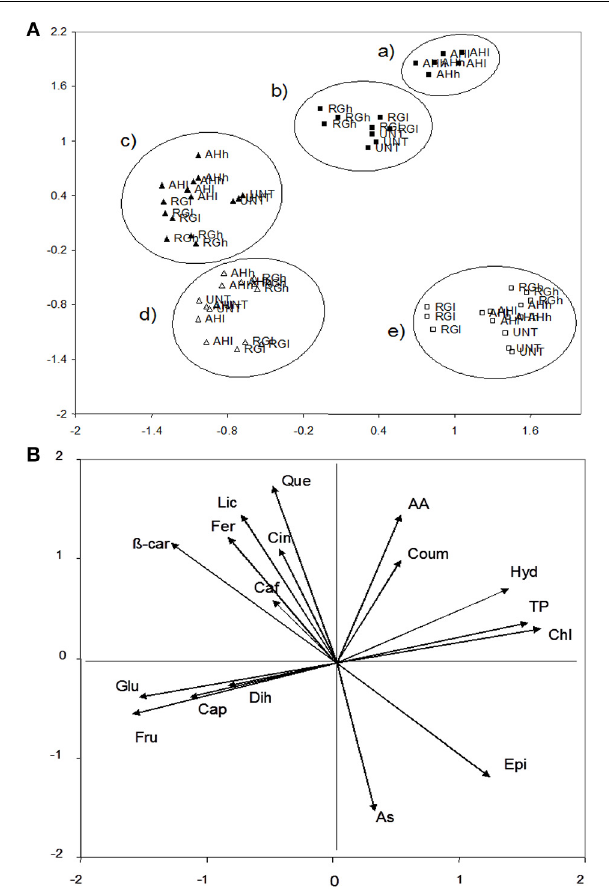
FIGURE 4 | PCA fruits scatterplot of the plants with and without biostimulants (upper, A) and the position of the variables projected in the plane as determined by the first two principal axes (lower, B) (85% explained variance). Alfalfa hydrolyzed (AH) and red grape (RG) biostimulants were at low (l) and high (h) doses, whereas no application was performed on the control (untreated, UNT). White and black symbols correspond to the 1st and 2nd application whereas the full square and triangle corresponded to the green and red fruits. AA, antioxidant activity; As, ascorbic acid; β -car, β -carotene; Caf, caffeic acid; Cap, capsaicin; Chl, chlorogenic acid; Cin, cinnamic acid; Coum, p -coumaric acid; Dih, dihydrocapsaicin; Epi, epicatechic acid; Fer, ferulic acid; Fru, fructose; Glu, glucose; Hyd, p -hydroxybenzoic acid; Lyc, lycopene; Que, quercetin; TP, total